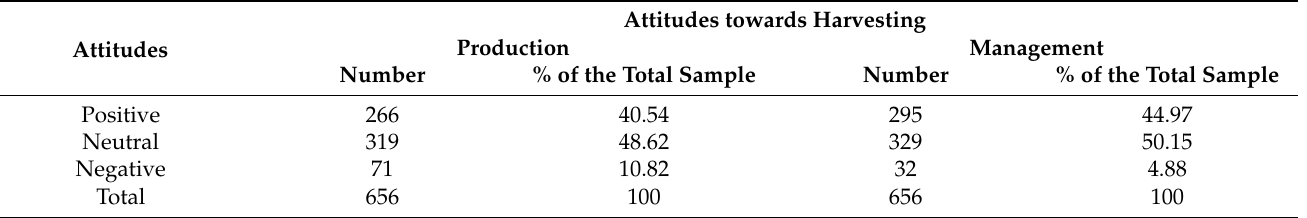
Table 6. Number and percent of survey respondents classified as having positive or negative attitudes towards harvesting trees for the purpose of timber production and management.